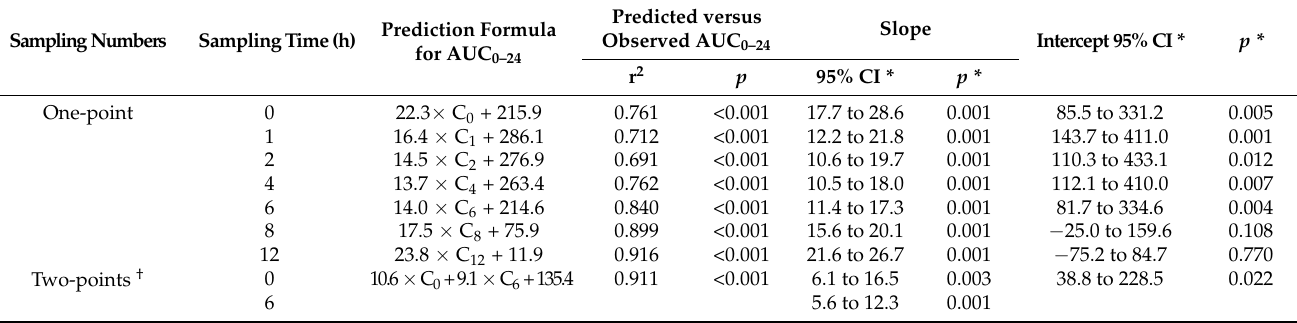
AUC 0–24 , area under the plasma concentration–time curve from 0 to 24 h; C n , plasma concentration at n h after afatinib administration. * Calculated using the bootstrap method. † Best sampling